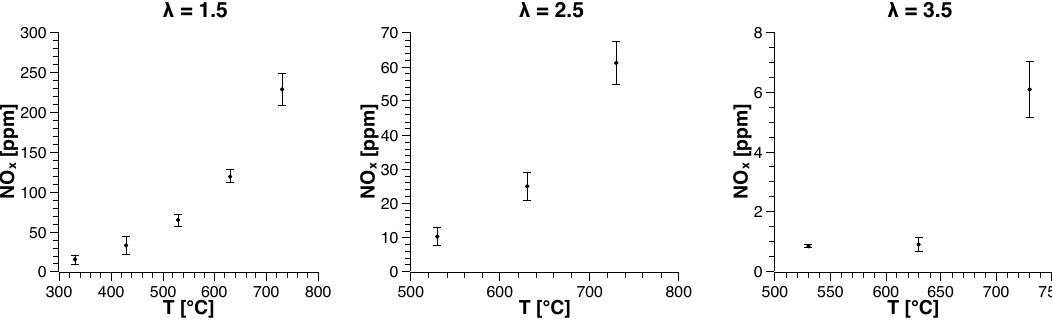
Figure 8. CO concentration (ppm) in the exhaust gases, normalized at 15% O 2 , as a function of the air inlet temperature for different values of the air-to-fuel ratio λ . λ = 1.5